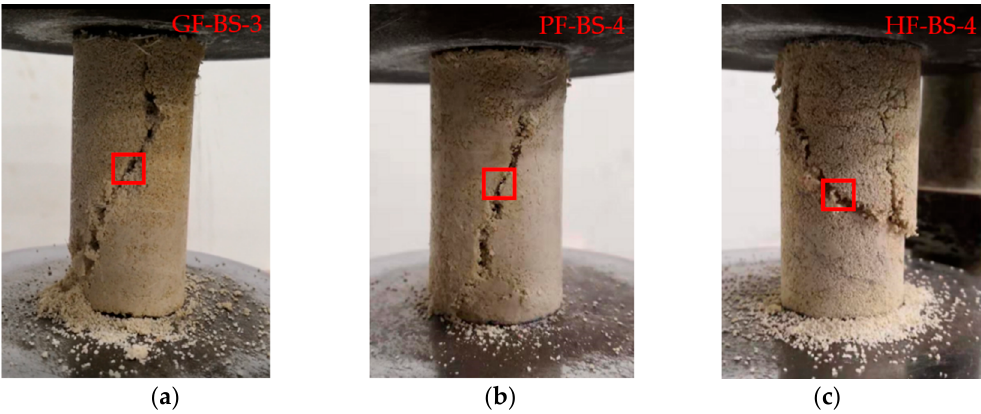
Figure 12. The specimens’ position was used for microscopic analysis: ( a ) GF-BS-3; ( b ) PF-BS-4; ( c ) HF-BS-4.